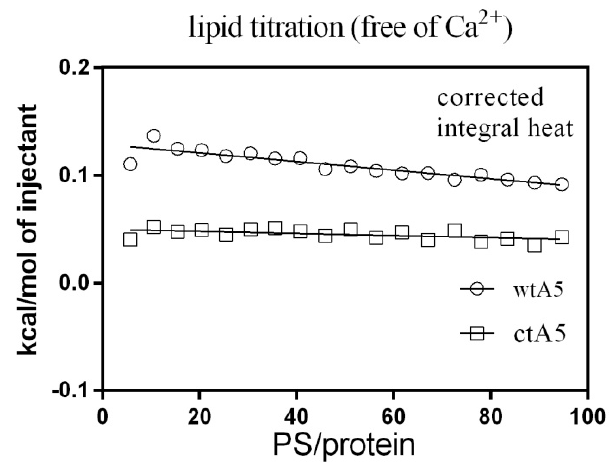
Figure 6. Titration of wtA5 and ctA5 with liposome in the absence of calcium. The data was processed and has been presented in the same way as indicated in Figure 5. Table 2. Parametric analysis of liposome titration.